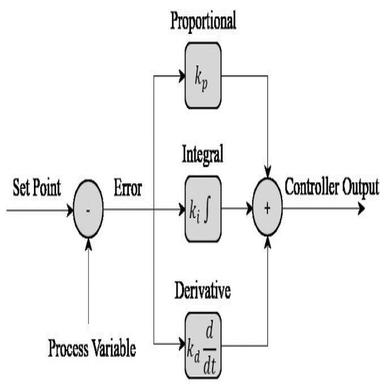
Block diagram of a basic PID control algorithm.